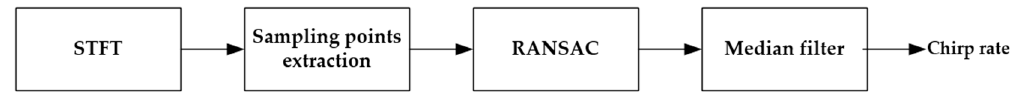
Figure 7. The flowchart of the chirp rate estimation.